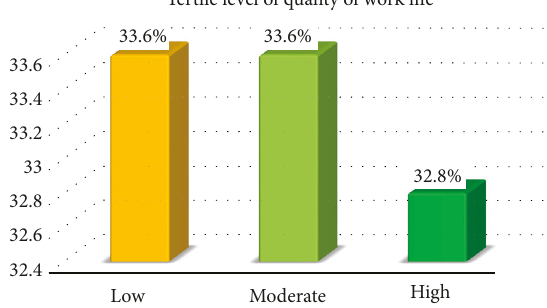
Figure 1: Tertile classification of quality of work life among nurses working in public health facilities of Hawassa town, March 10–27,